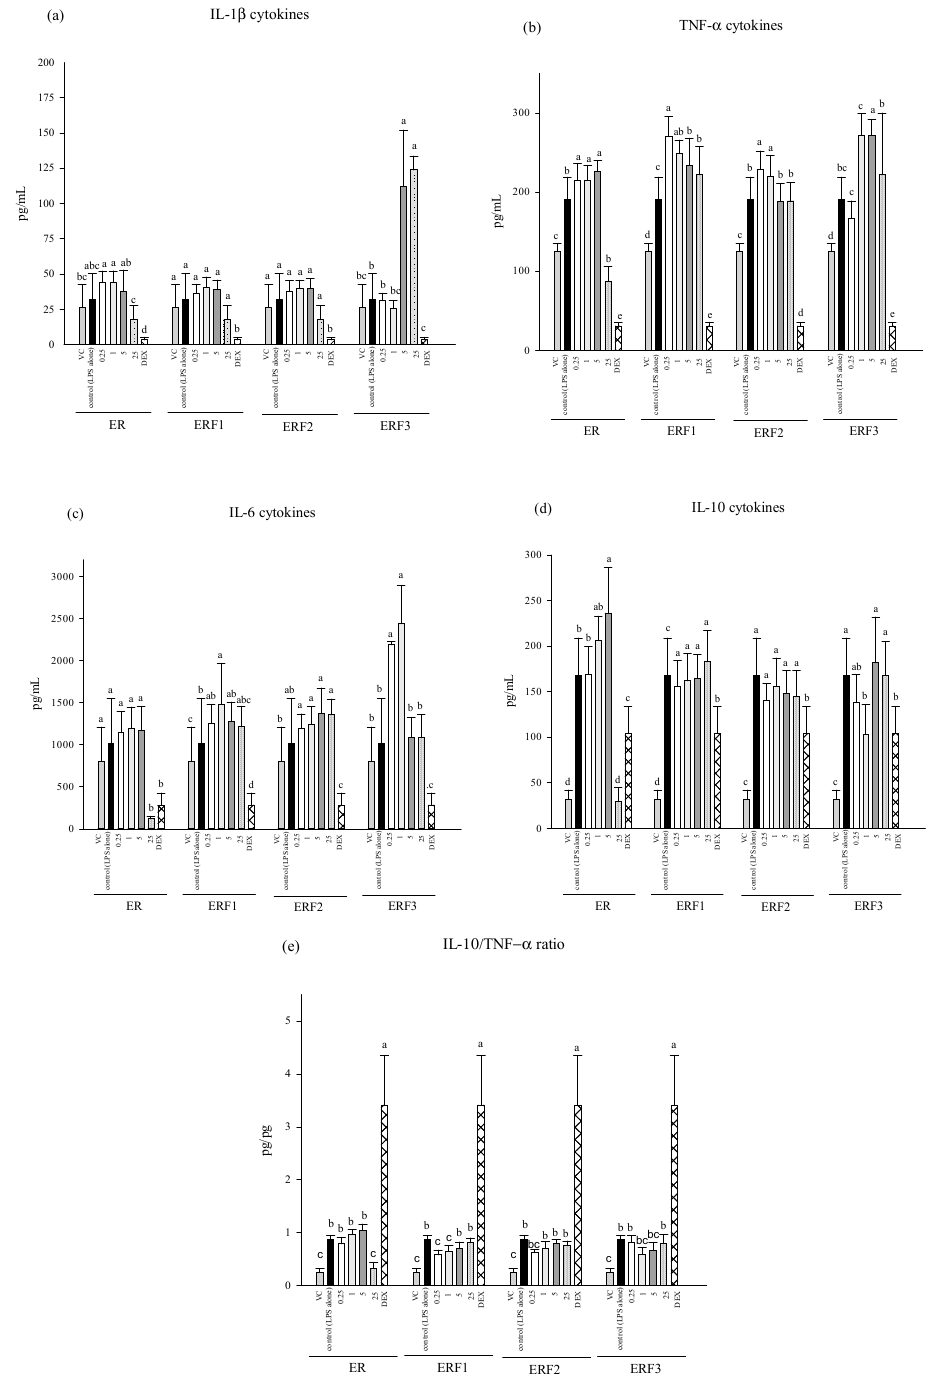
Figure 3. Effect of treatments with different concentrations of steam distilled essential oils of ER, and fractions 1–3 on IL-1 β ( a ), TNF- α ( b ), IL-6 ( c ), IL-10 ( d ), and IL-10/TNF- α ( e ) cytokine secretions ratios by LPS-stimulated peritoneal macrophages from female BALB/c mice in vitro. Data are presented as the mean ± SD ( n = 6 biological determinations). Bars in the same plot within the same sample item not sharing a common letter are significantly different ( p < 0.05) from each other assayed by one-way ANOVA, followed by DuncaN (cid:48) s multiple range test. Each cell population (5 × 10 6 cells/mL medium) was, respectively, treated with the Euodia ruticarpa (ER) SDEO, and fractions 1–3 at the indicated concentrations of 0, 0.25, 1, 5 and 25 µ g/mL. The detection sensitivity of cytokine ELISA kits used in this study was <15.6 pg/mL. VC: vehicle